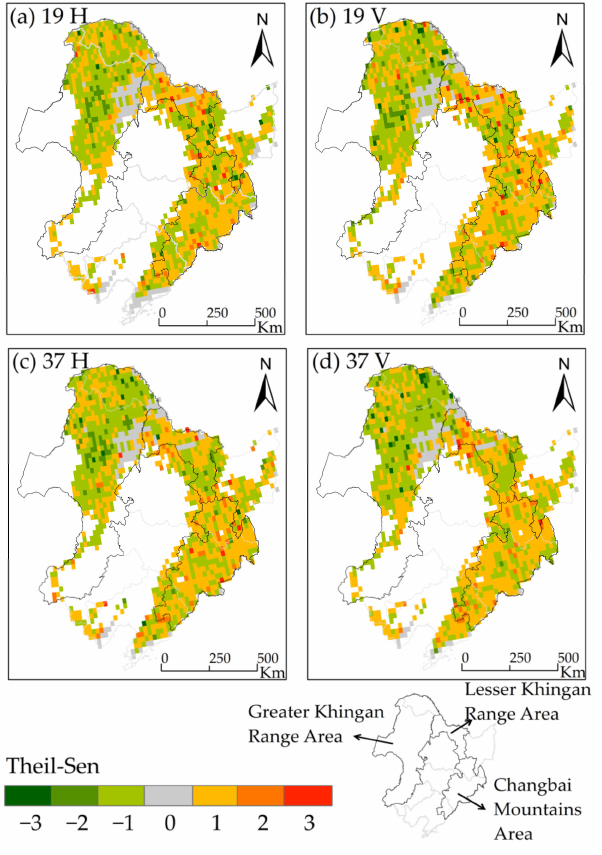
Figure 6. Theil Sen trend analysis of transmissivity for five consecutive years from 2014 to